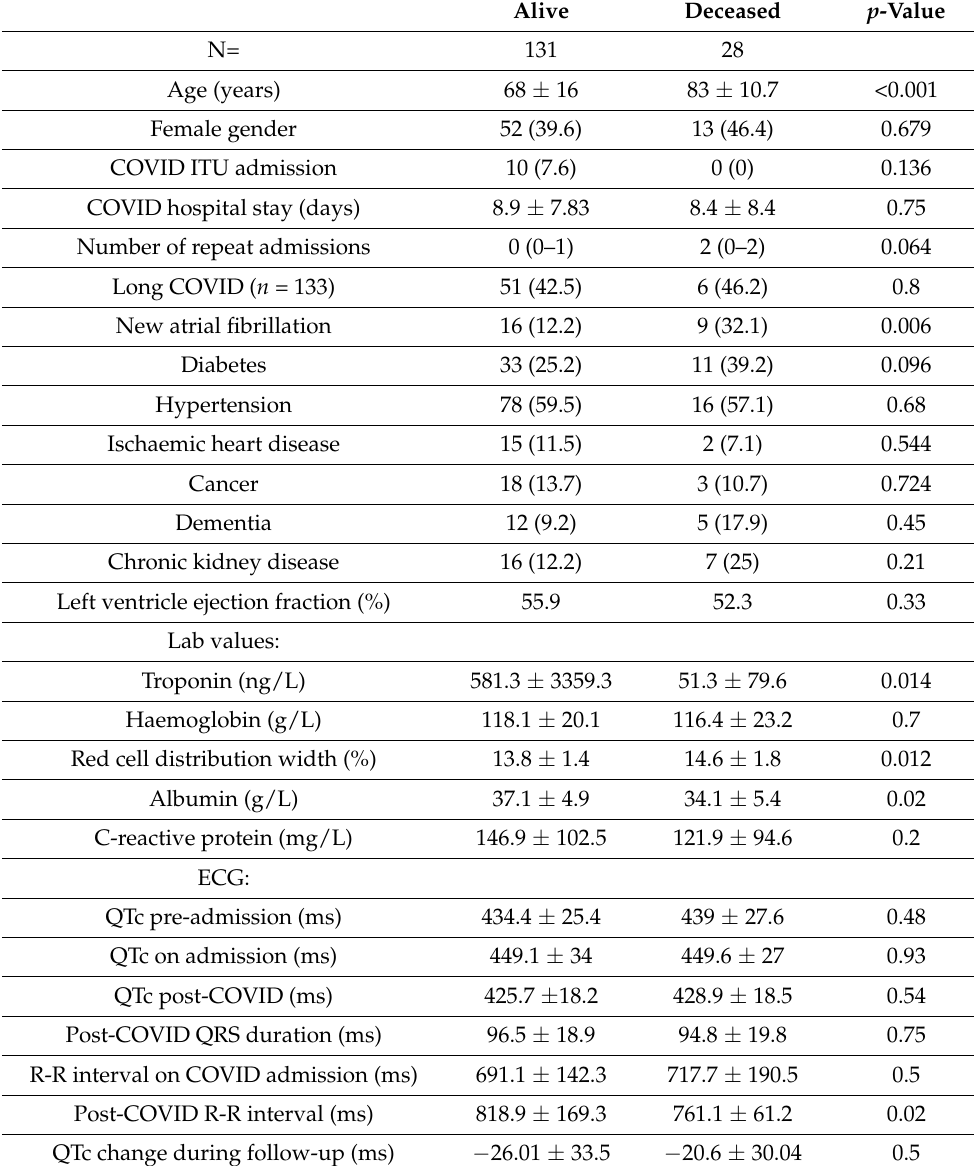
Table 2. A comparison of patients who, at 1-year follow-up, were either alive or deceased. The deceased cohort was older, with a shorter post-COVID R-R